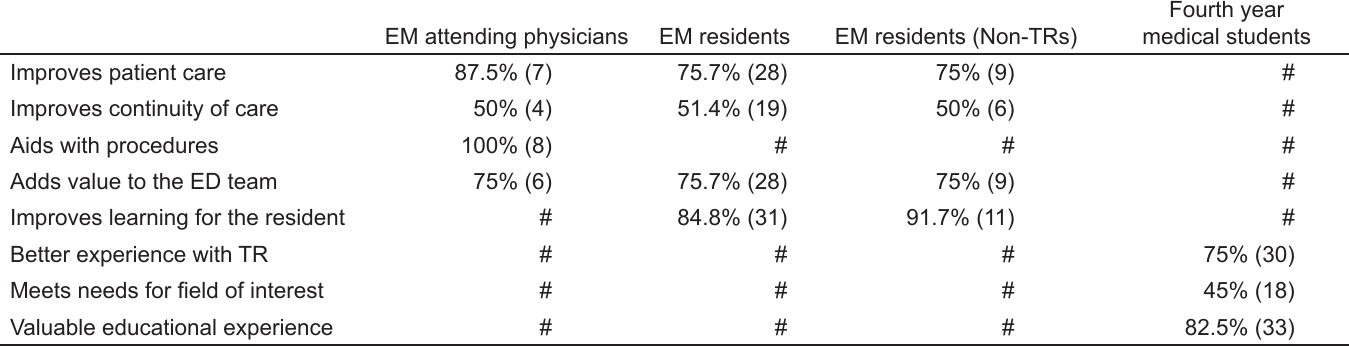
Table 2b. Subject agreement with characteristics of the teaching-resident (TR) position and its effects on the emergency department (ED) – comparison response view. Values reported are percentage (absolute number) of respondents indicating “somewhat agree” or